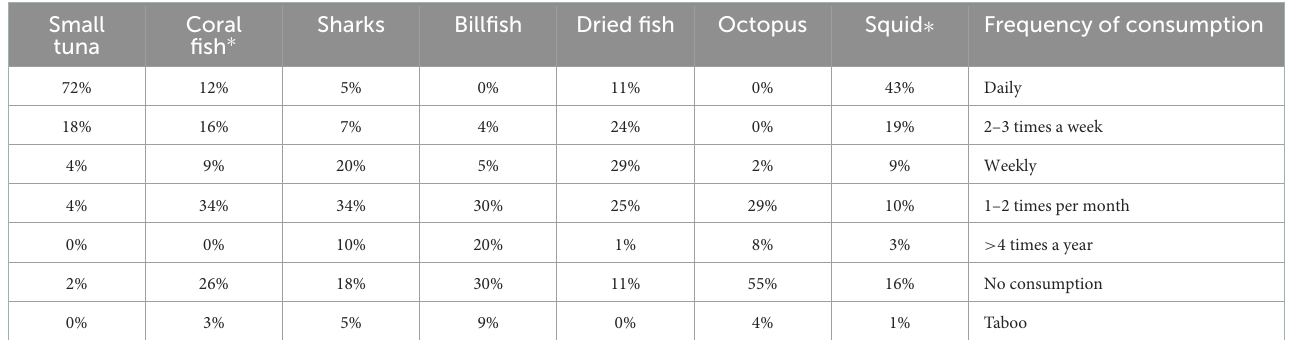
TABLE 3 Frequency of consumption of marine products. Small